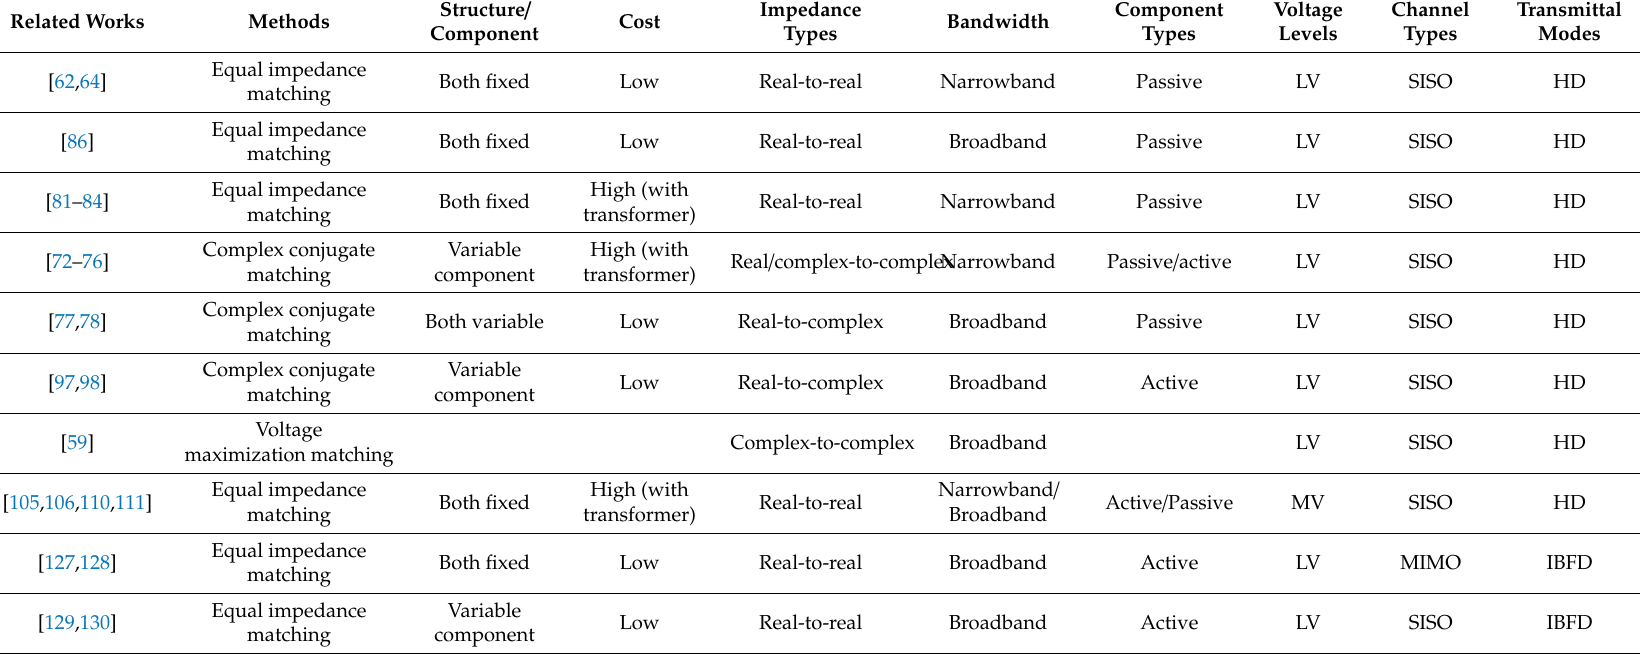
Table 4. Review of related works in